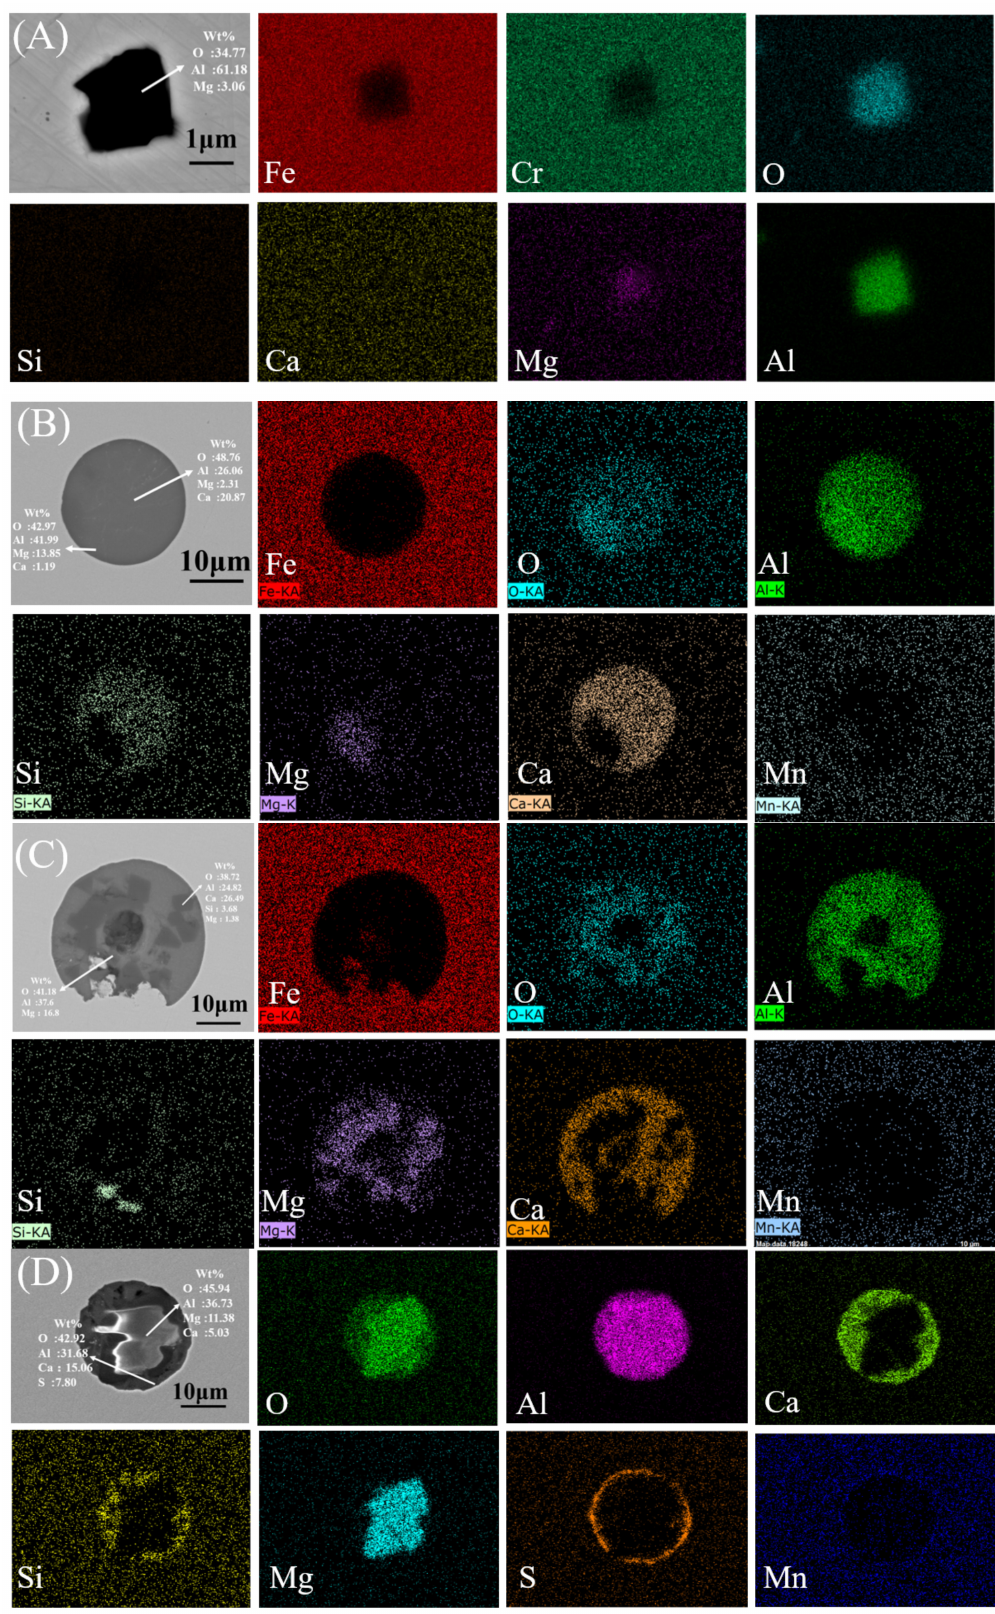
Figure 3. Elemental distribution maps of typical inclusions at each stage. ( A ) Typical Al 2 O 3 –MgO inclusion in sample VD-end, ( B ) typical CaO–Al 2 O 3 –SiO 2 –MgO inclusion in sample LF-end, ( C ) Typical CaO–Al 2 O 3 –SiO 2 –MgO inclusions in sample VC-onset, and ( D ) typical CaO–Al 2 O 3 –SiO 2 –MgO–CaS inclusions in sample